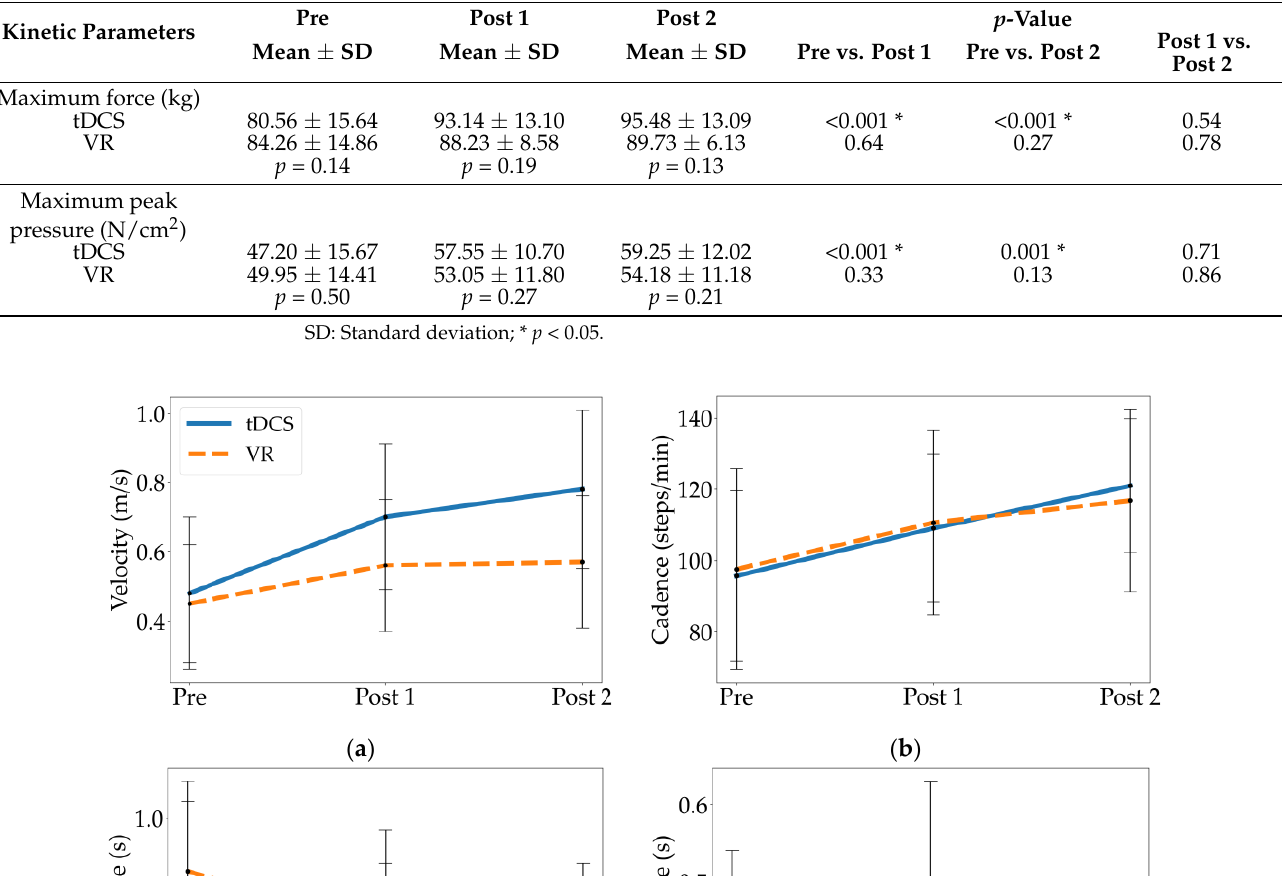
Table 4. Between-group and within-group comparisons of kinetic parameters at Pre, Post 1, and Post 2. Between Group Within Group